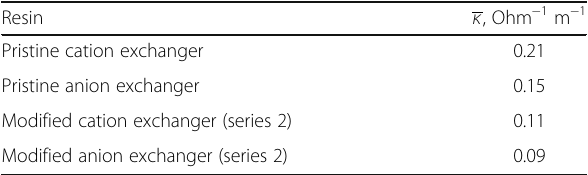
Table 2 Electrical conductivity of H – (OH) forms of the resins measured in deionized water